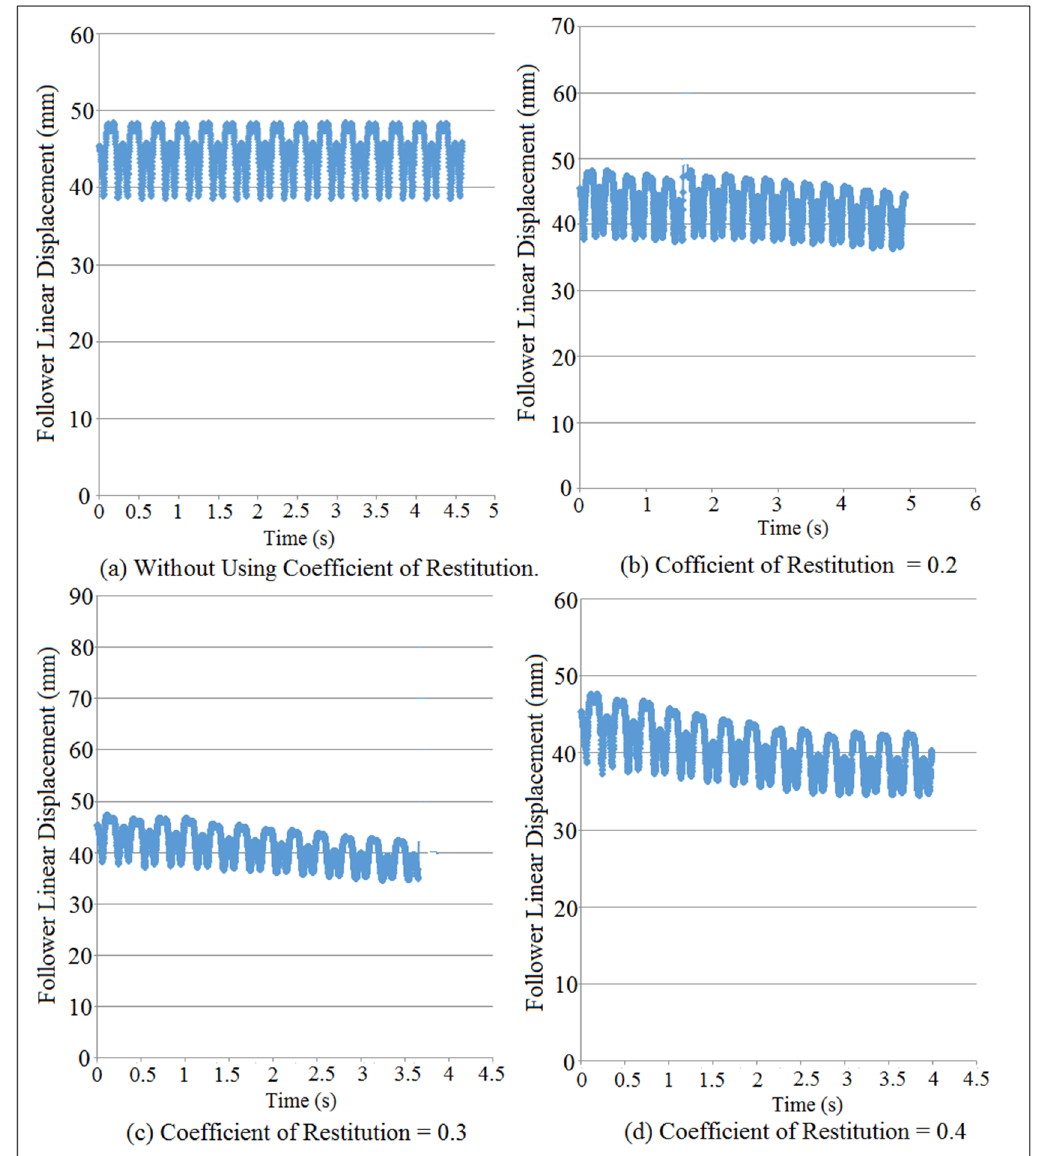
Figure 11. Follower linear displacement mapping against time at different values of coefficient of restitution. In this paper, the cam profile with return-dwell-rise-dwell-return-dwell-rise-dwell- return-dwell-rise-dwell was selected, [23]. The system with (I.D. = 16 mm) and (N = 200 rpm) was used in the verification of the follower displacement as shown in Figure 12 for one cycle of cam rotation.